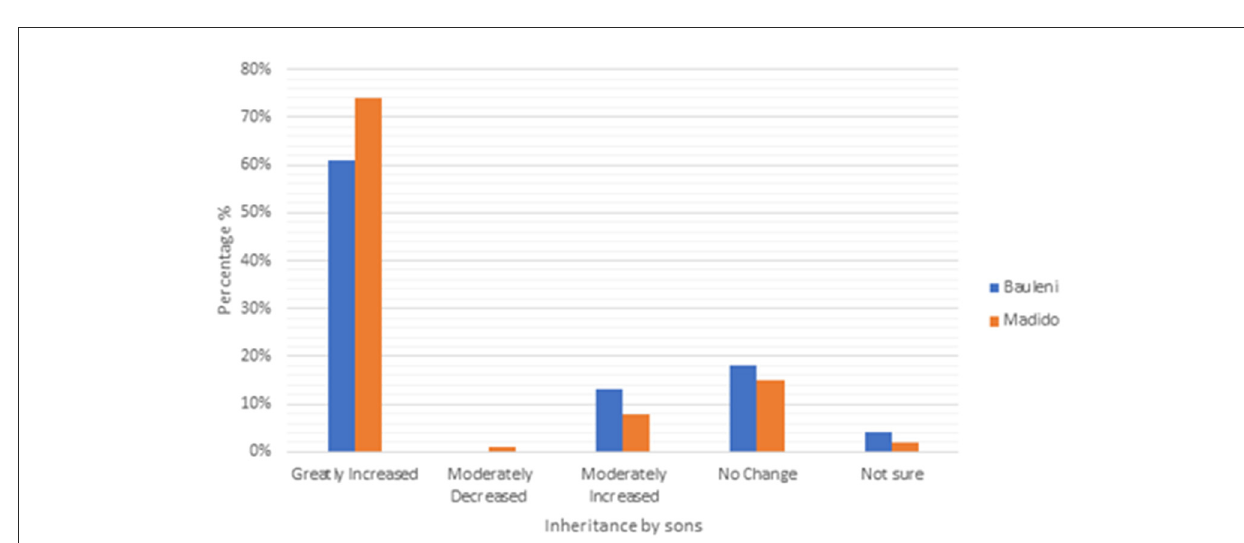
FIGURE6 Inheritance of property rights by sons in Bauleni and